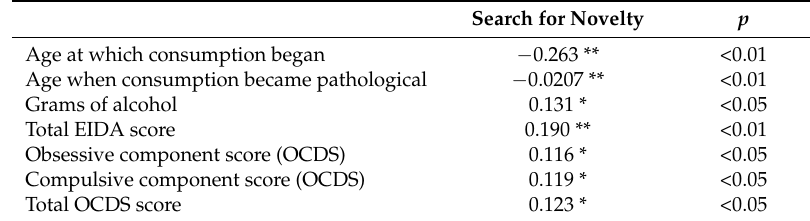
Table 1. Statistically significant correlations between Search for Novelty (TCI-R) and severity factors of the EIDA, OCDS and EuropAsi scales. (* p < 0.05; ** p < 0.001).